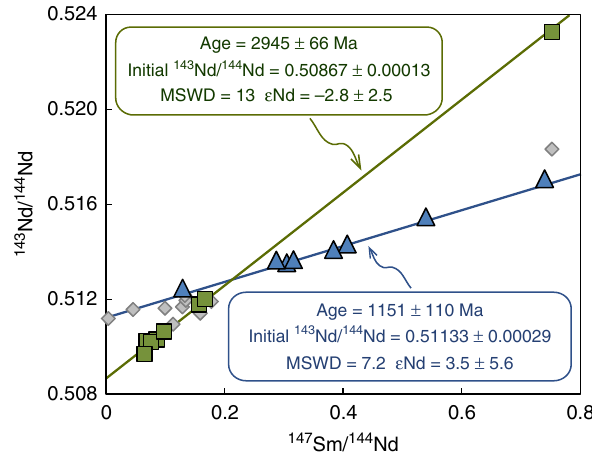
Fig. 4 Sm-Nd isochron diagram for Venetia garnet inclusions. The two isochrons are distinguished based on T DM and CaO of the samples. Green square symbols represent the 3.0 Ga age group samples with lower than 2.5 wt.% CaO; blue triangles represent the 1.1 Ga age group with higher than 2.5 wt.% CaO. The analytical errors are smaller than symbol